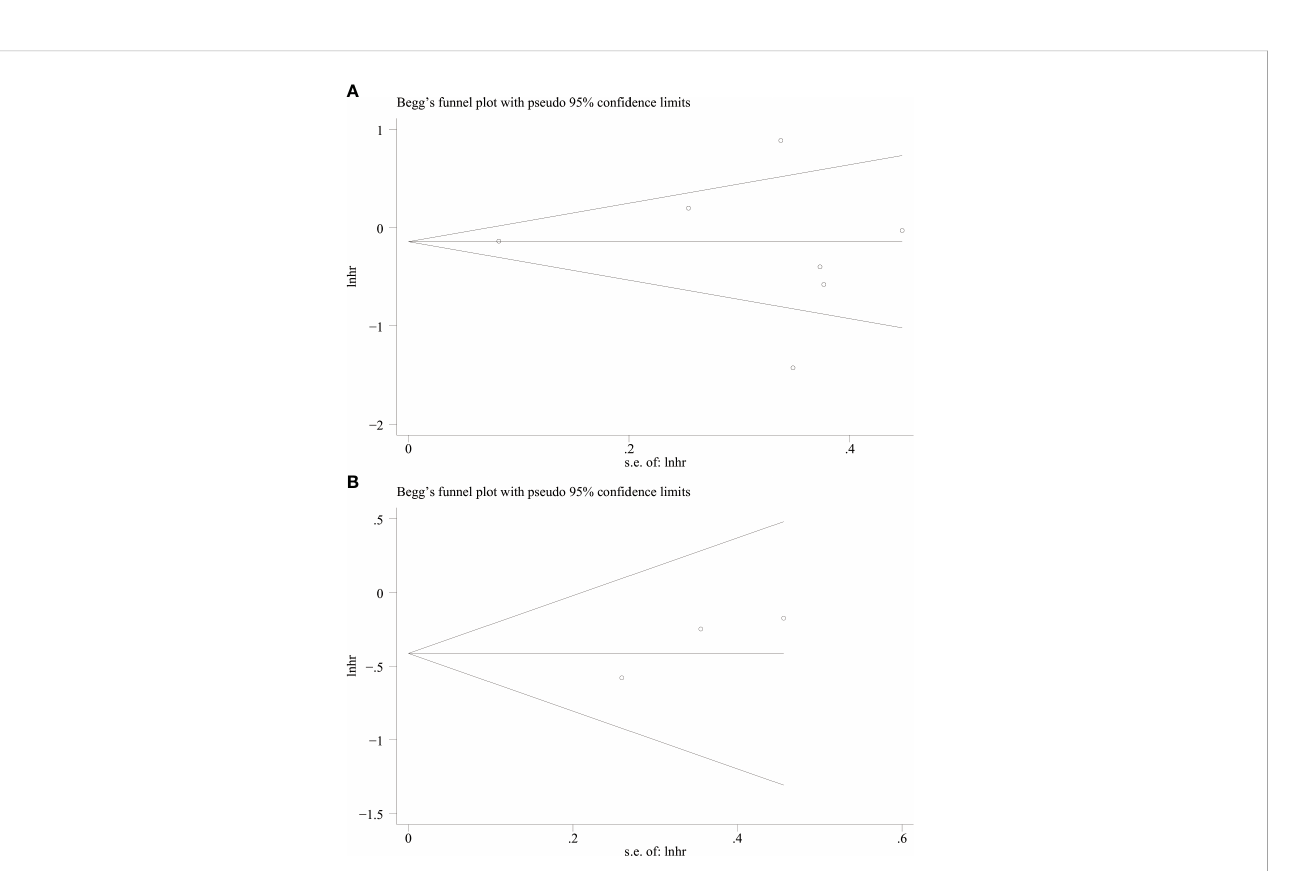
FIGURE 8 Begg ’ s funnel plot for OS (A) and DFS (B)